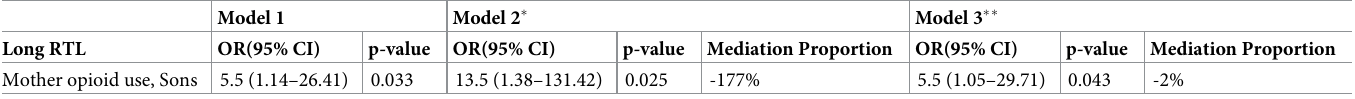
Table 3. Mediation (suppressor) effect of neonate weight on the association between OM and long telomere. Model